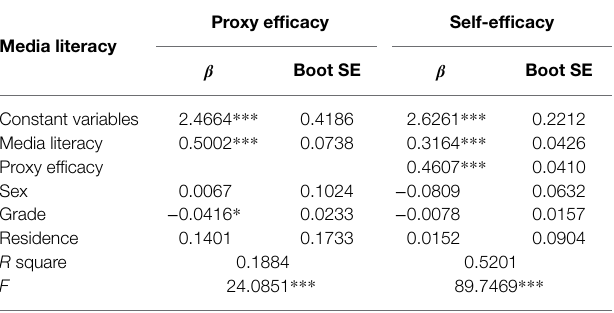
TABLE 3 | The mediation effect of proxy efficacy between media literacy and self-efficacy.